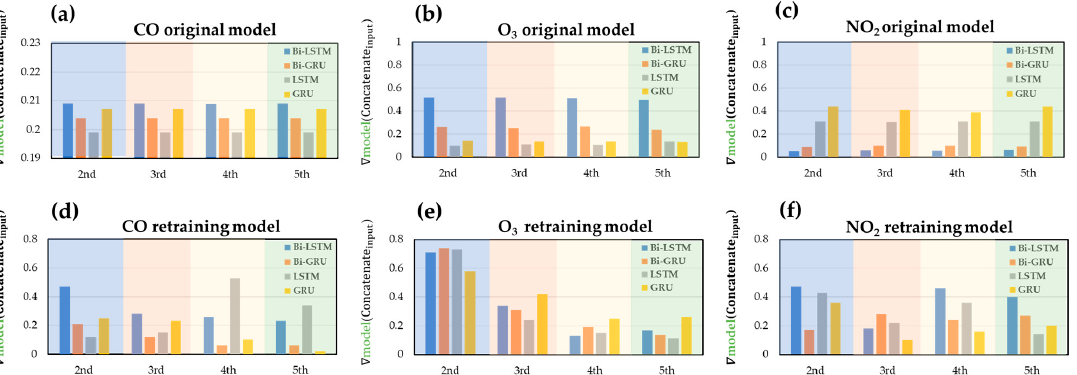
Figure 18. The gradient contributions of the static models in the original ensemble model for ( a ) CO, ( b ) O 3 , and ( c ) NO 2 gases and in the retrained ensemble models for ( d ) CO, ( e ) O 3, and ( f ) NO 2 gases.